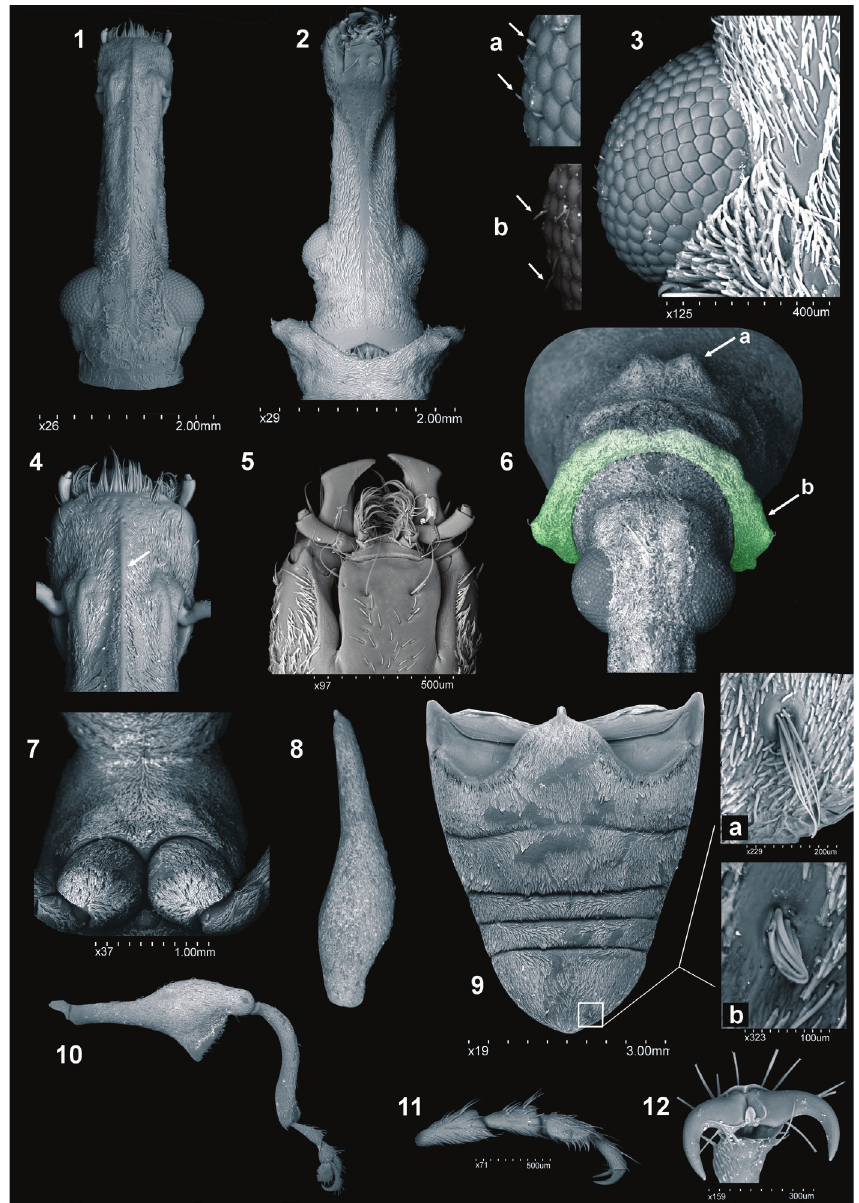
Figures 1–12. General morphology of Callistomorphus : 1 C. farinosus Perr., head and rostrum, dorsal view 2 C. malleus sp. n., head and rostrum ventral view 3 C. fundatus sp. n., ventral view of eye with magnification of setae between ommatidia ( a C. fundatus sp. n., b C. gibbus sp. n.) 4 C. farinosus Perr., apical part of rostrum with antennal insertion, dorsal view 5 C. turbidus sp. n., mouth parts 6 C. gibbus sp. n., head and pronotum, frontodorsal view; a medial tubercles on pronotum, b thickened front “wall” of pronotum (greened) 7 C. rutai sp. n., fore coxae 8 C. gibbus sp. n., hind femur, dorsal view 9 C. fundatus sp. n., abdomen a C. torosus sp. n. b C. fundatus sp. n., apical setae on last ventrite 10 C. malleus sp. n., hind leg, lateral view 11 C. turbidus sp. n., hind tarsus 12 C. rutai sp. n., tarsal